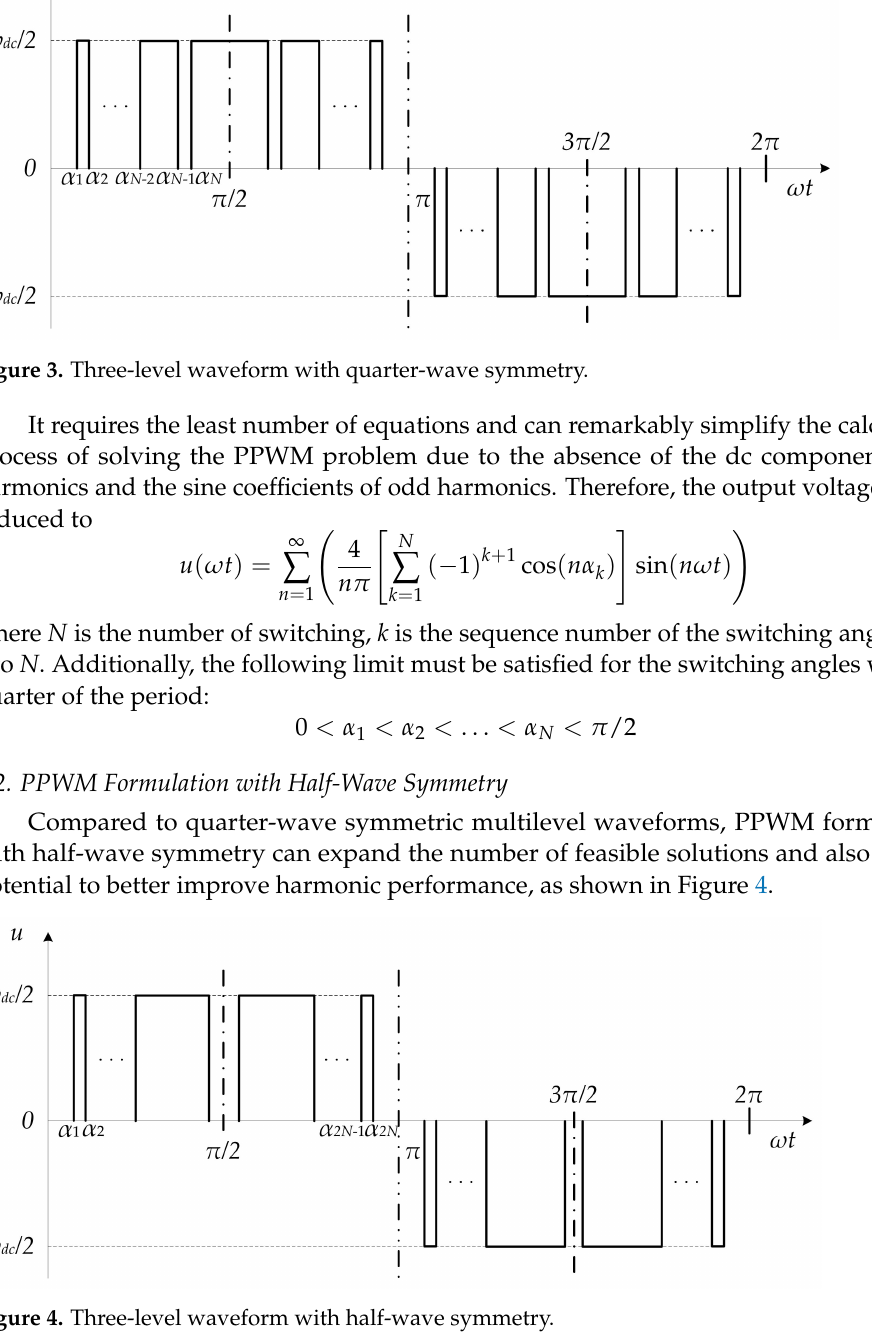
Figure 4. Three-level waveform with half-wave